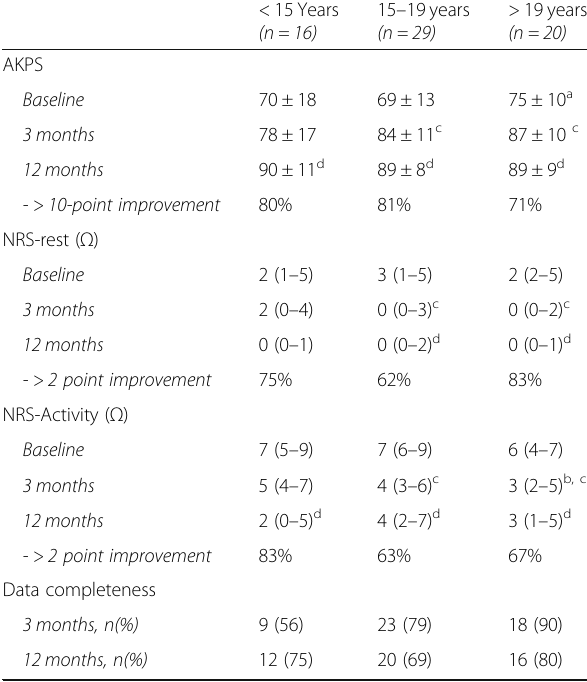
Table 3 Comparison of outcome scores in relation to age